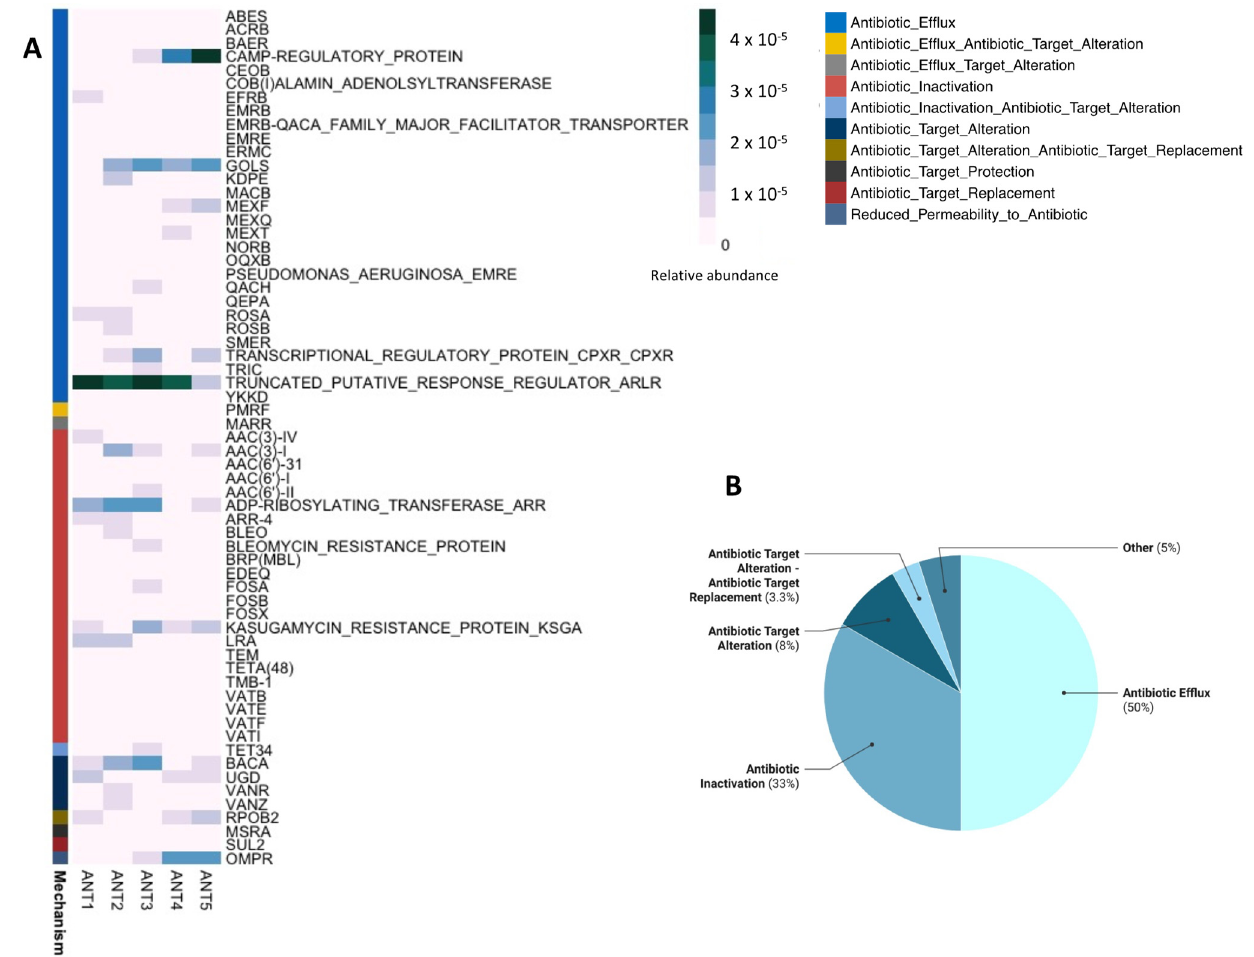
Figure 2. Relative abundance of ARG families in Deception Island ( A ) and their associated resistance mechanisms ( B ). Relative abundance in ( A ) was calculated by dividing the number of ARGs by the total ORFs number per sample. Percentages in ( B ) were calculated as the proportion of each ARGs mechanisms in the total number of detected ARGs.